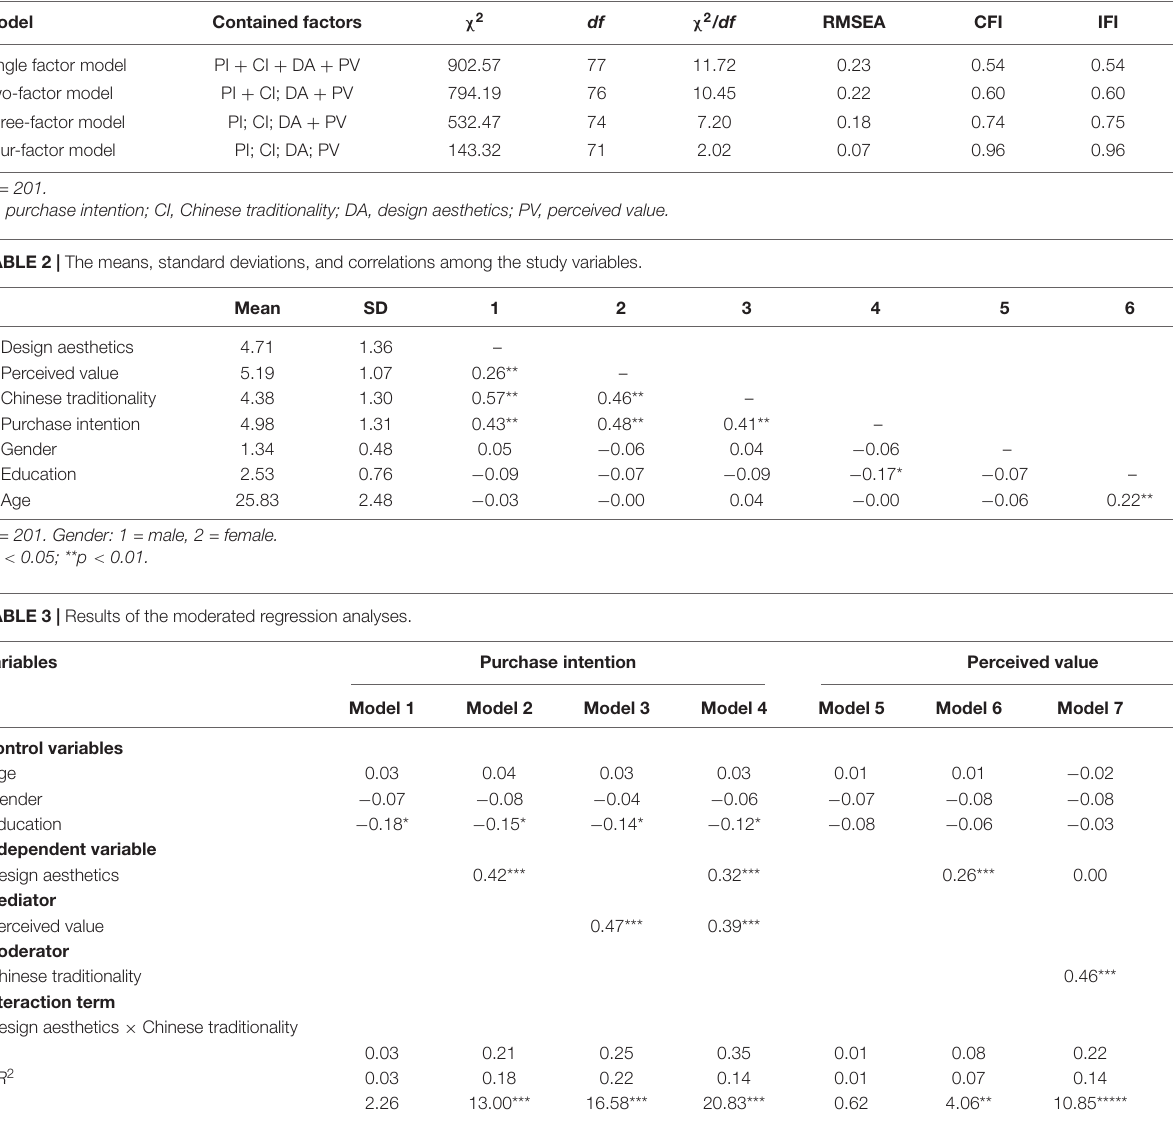
TABLE 1 | Results of confirmatory factor analysis.